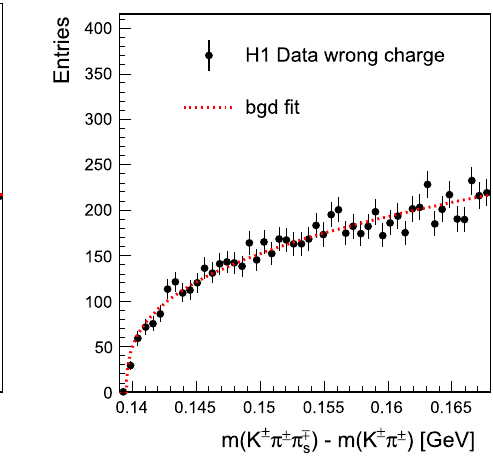
sample with the background-only fit, performed simultaneously under the assumption of identical background shape in the right charge com- binations, is shown in the right figure as the dotted